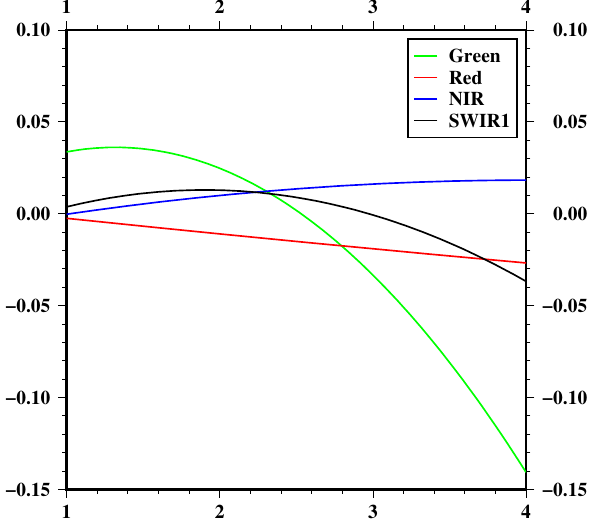
Figure 7. Temporal offset model of classification trees for band Green, Red, NIR, SWIR1 of Sentinel-2 MSI.